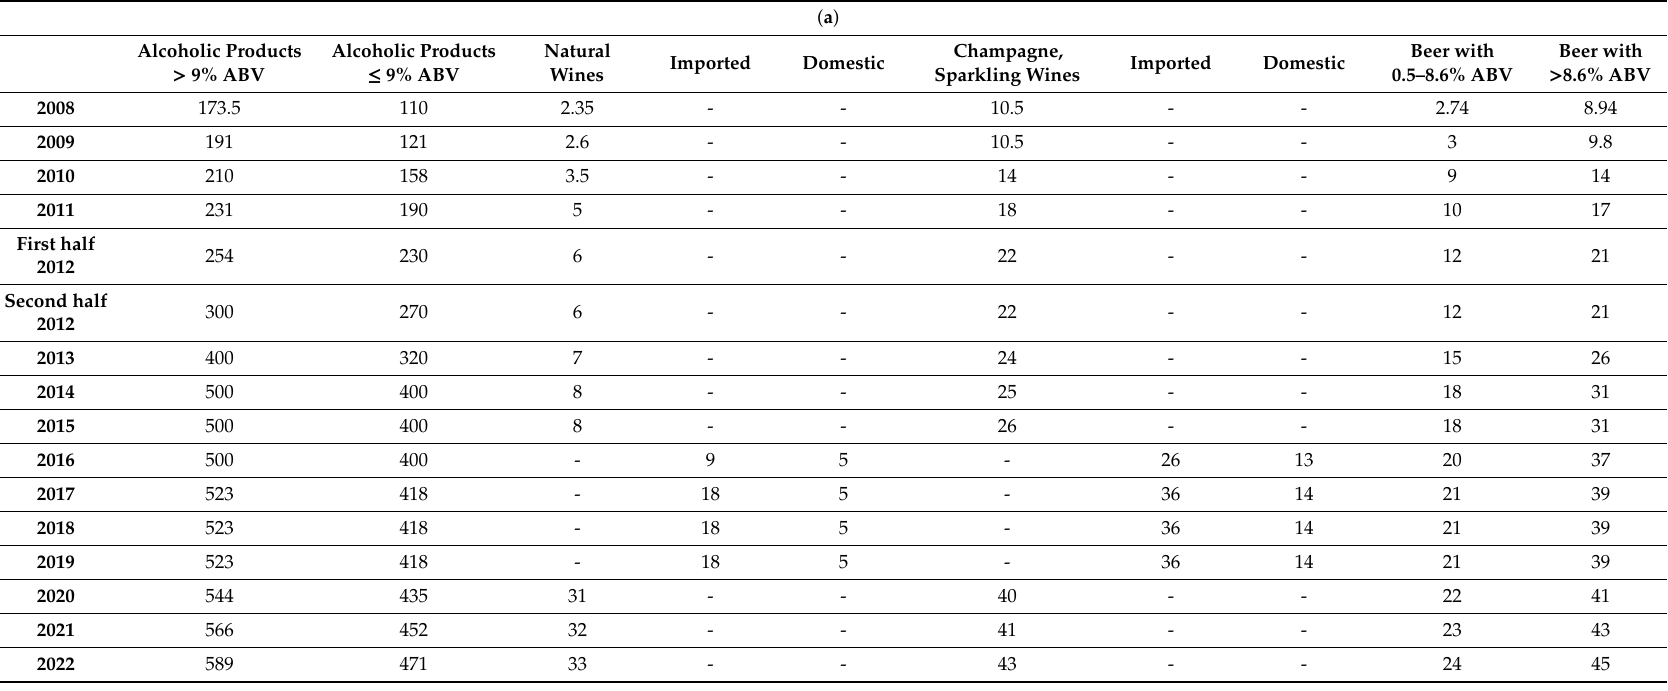
Table A4. ( a ) Excise rates on alcoholic beverages in rubles per liter. Sources: Russian Tax Code and the Federal Statistical Service. ( b ) Excise rates on alcoholic beverages in rubles per liter, adjusted for inflation using consumer price index (CPI) percentages for alcoholic beverages for each year. For the adjustment of excise rates for the period 2020–2022, the CPI of 2019 was taken. Sources: Russian Tax Code and the Federal Statistical